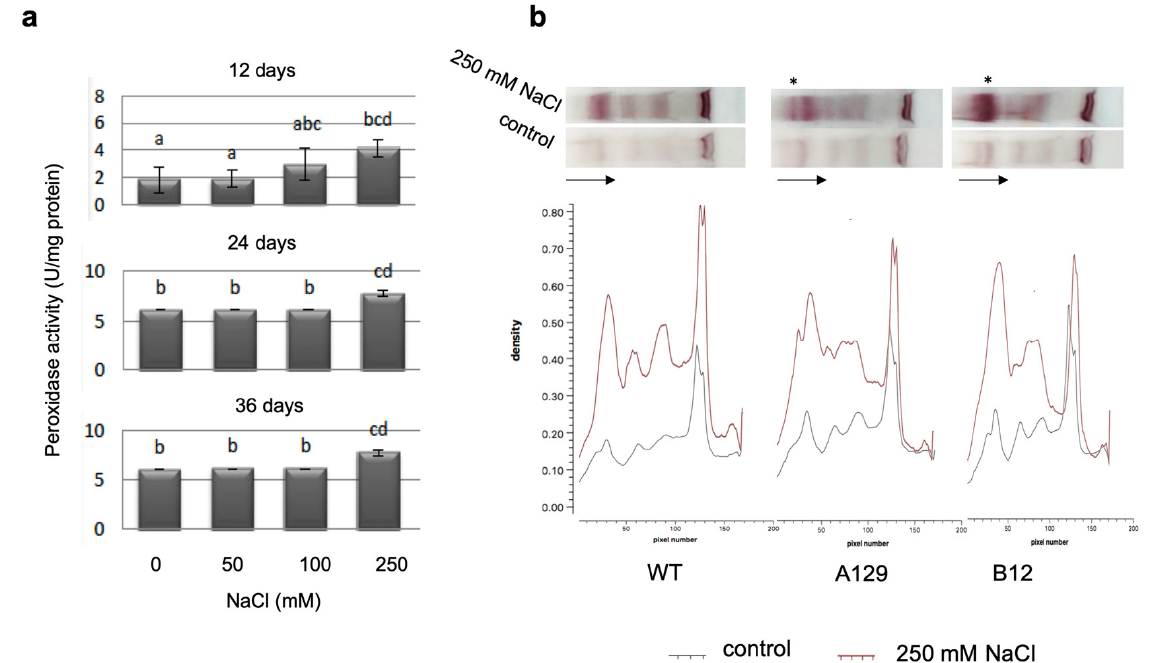
Figure 9. Peroxidase activity of WT determined with OPD ( a ) and isoenzyme separation of WT and two mutant lines on native polyacrylamide gels using benzidine-guaiacol for visualization ( b ). Bars with different letters are significantly different at p < 0.05. Since the mutant lines did not show any difference to WT in their response to salt stress with the parameters determined in ( a ), the complete dataset including the gel stained with Coomassie blue is displayed in the Supplementary Materials (Figures S4 and S7). The density of the bands in ( b ) was detected using the GelEval software free trial version 1.35 (FrogDanceSoftware, Cambridge, UK). The asterisks mark differences between WT and mutant lines in the peroxidase isoenzyme pattern. The arrows show the direction of sample flow.